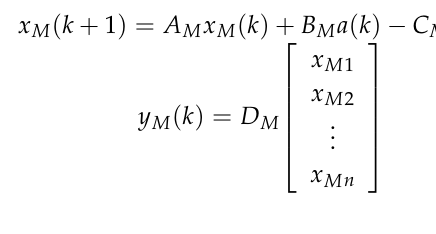
Figure 4. Structure of an n th order 1-bit ∆∑ modulator.